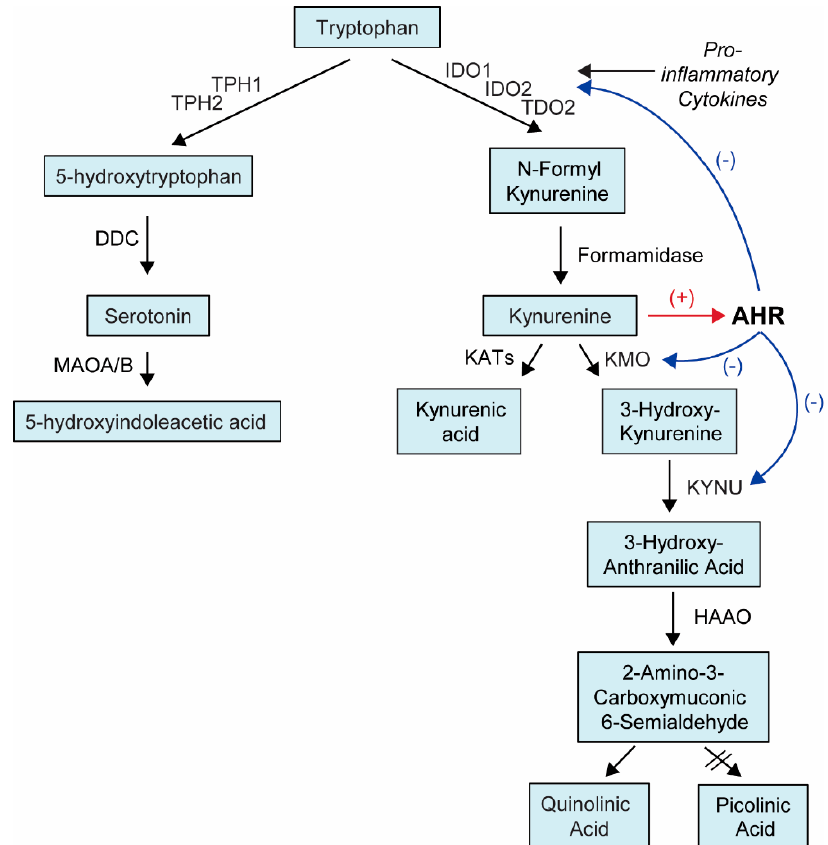
Figure 2. Tryptophan Metabolism Pathway. Tryptophan is metabolized by two main pathways: the serotonin pathway (~1% of tryptophan metabolism) and the kynurenine pathway (~95% of tryptophan metabolism). The rate limiting enzymes IDO1/2 can be induced with pro-inflammatory cytokines, resulting in the production of more kynurenine, which is an agonist for AHR. AHR can also regulate the expression of IDO1/2, TDO2, KYNU, and KMO. The black arrows indicate enzymatic reactions, the red arrows indicate positive (+) regulation and the blue arrows indicate negative ( − ) regulation. DDC: dopa decarboxylase; HAAO: 3-hydroxyanthranilate 3,4-dioxygenase; IDO: indoleamine 2,3-dioxygenase; KATs: kynurenine amino transferases; KMO: Kynurenine 3-Monooxygenase; KYNU: Kynureninase; MAOA/B: monoamine oxidase A/B; TDO2: tryptophan 2,3-dioxygenase; TPH1/2: tryptophan hydroxylase.